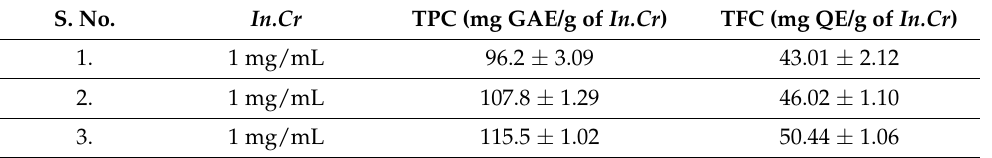
Table 2. Total phenolic and flavonoid contents of In.Cr . S. No. In.Cr TPC (mg GAE/g of In.Cr ) TFC (mg QE/g of In.Cr )